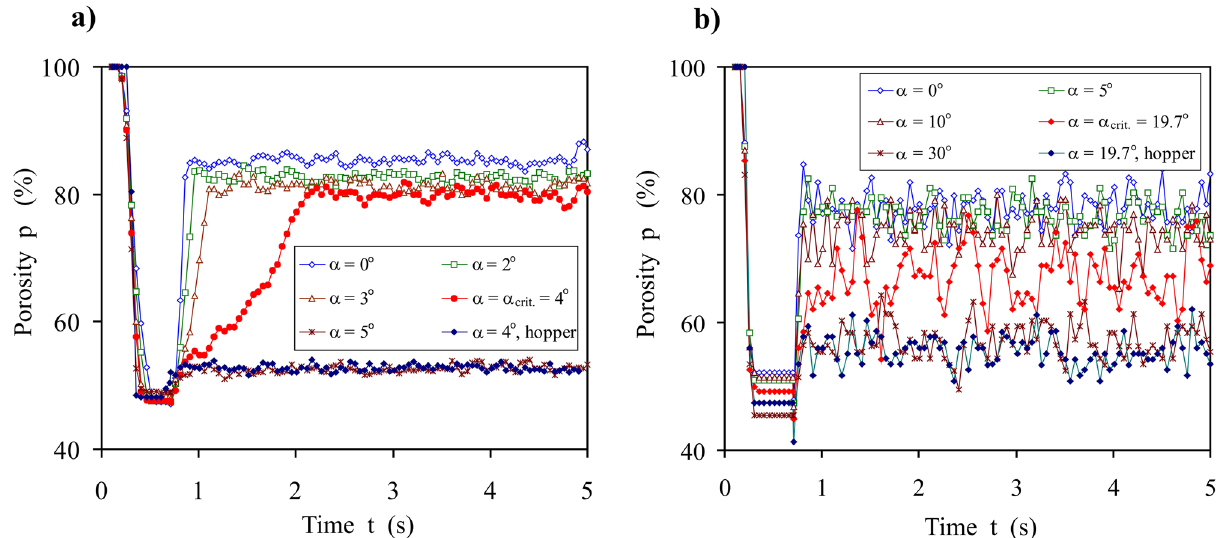
Figure 8. Porosity of the granular assembly inside the volume of the orifice of d 0 = 32.5 mm vs. time during filling, detention, and discharge for: ( a ) h = 100 mm, ( b ) h = 12